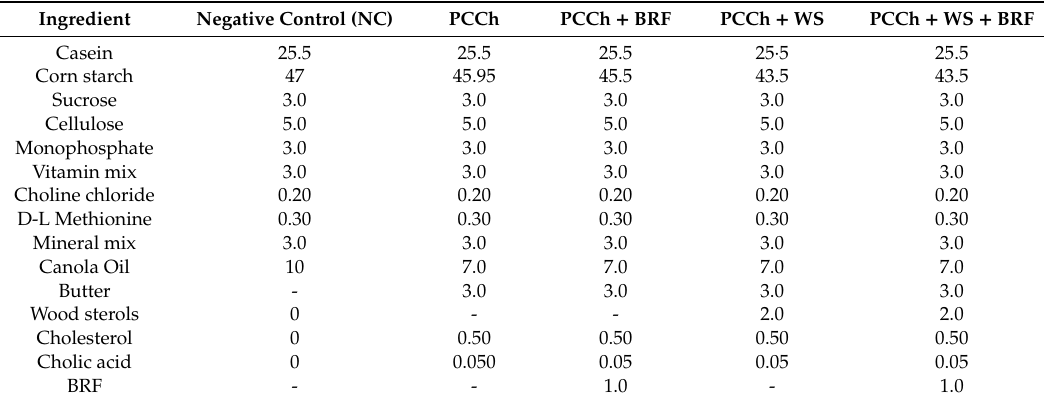
Table 5. Experimental diet compositions (g / 100